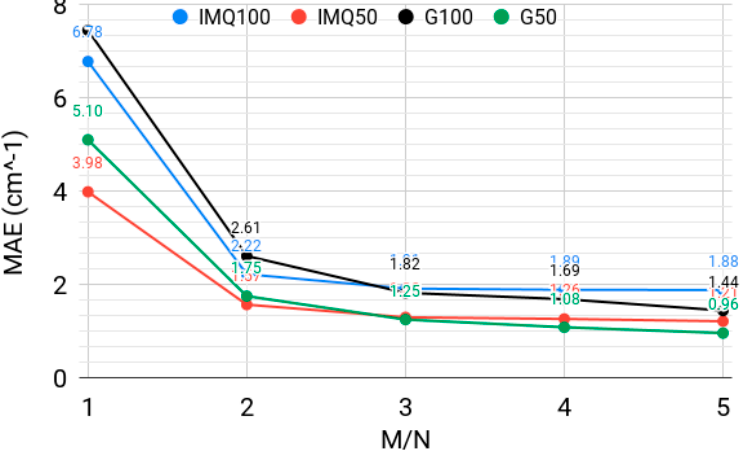
Figure 3. The mean absolute error (MAE), in cm − 1 , over the lowest 50 and 100 vibrational levels of H 2 CO, computed with a width-optimized inverse multiquadratic (IMQ50, IMQ100) basis with β = 7 and a width-optimized multiquadratic Gaussian (G50, G100) basis, for N = 30,000 basis functions and different ratios of the number of collocation points to the number of basis functions M : N .